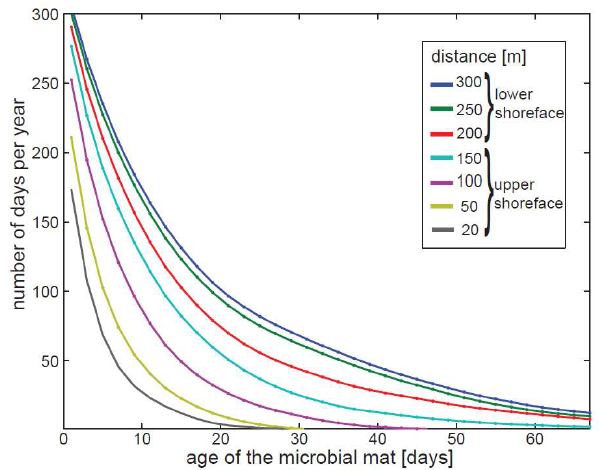
Figure 9. Frequency distribution of the age of microbial mats. The ages were computed using a simple model for microbial mat growth and destruction at different locations along the modeled shore profile (see Figure 7).